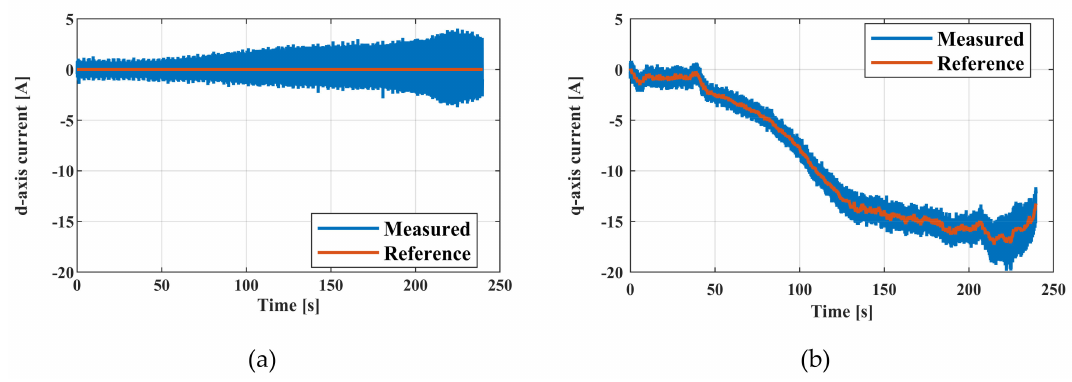
Figure 15. Comparison between reference and measured currents: ( a ) d -axis current; ( b ) q -axis current.